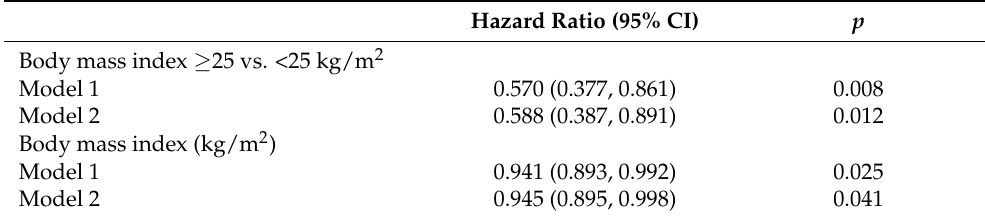
Table 4. Effect of body mass index on all-cause mortality in the validation